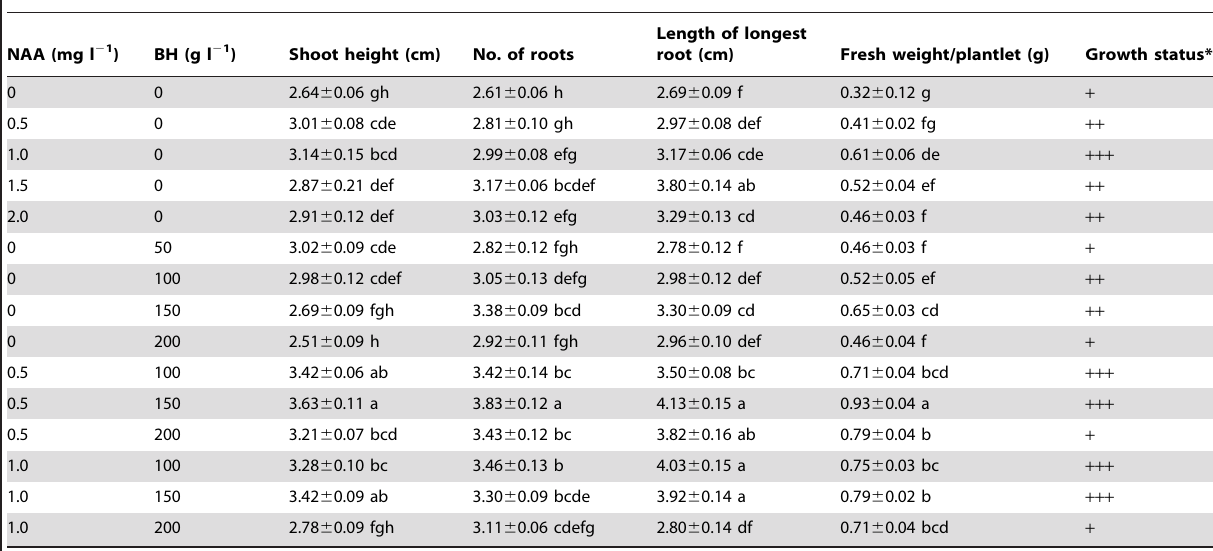
Table 6. Effect of NAA and banana homogenate (BH) concentration on Renanthera imschootiana plantlet growth on